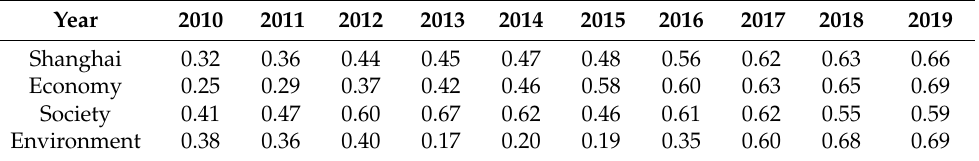
Table 3. Urban vitality comprehensive index for Shanghai from 2010 to